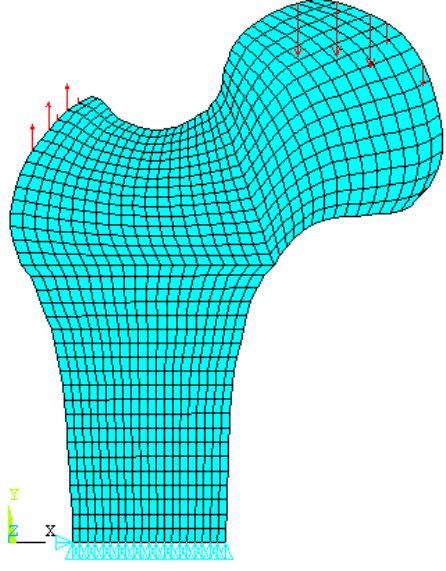
Fig. 2 2-D finite element model of the